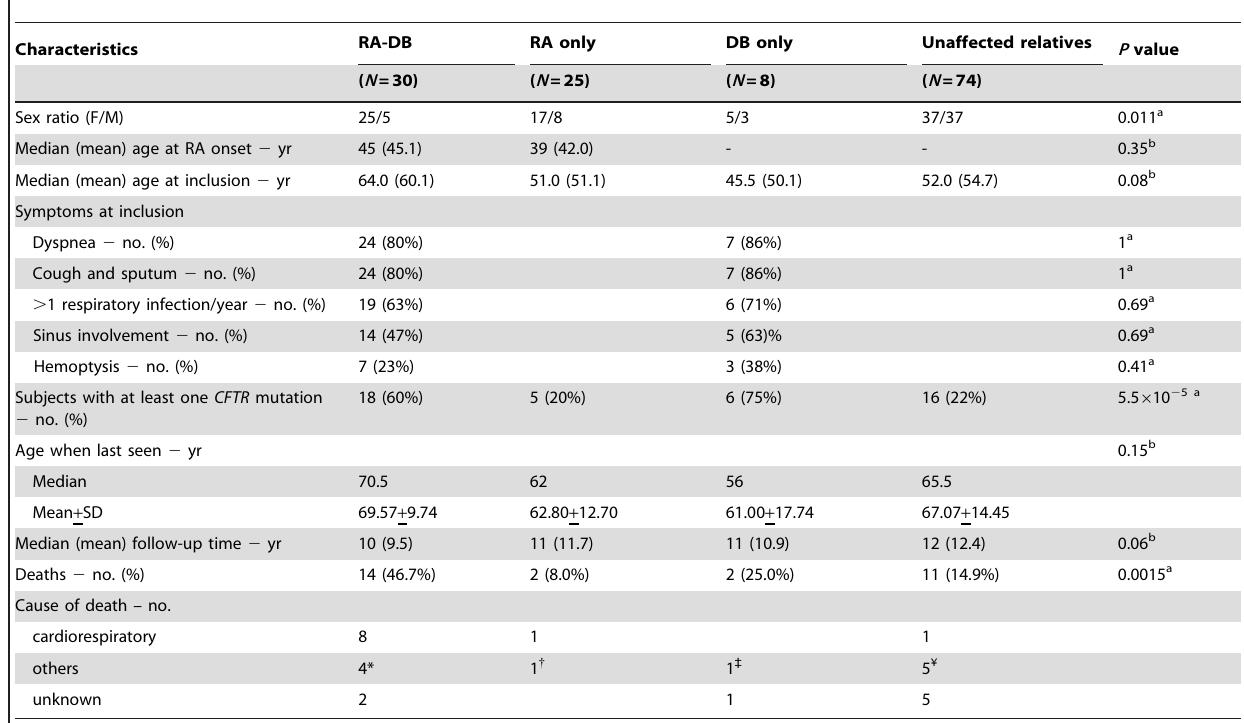
Table 1. Characteristics and outcome of the 137 participants in the family-based cohort study.